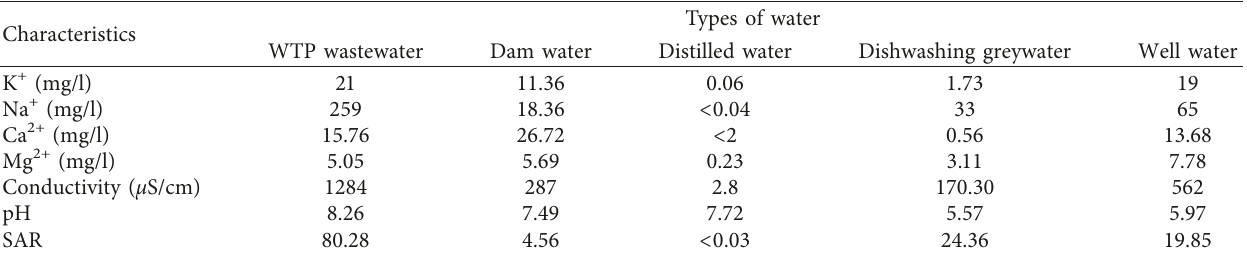
Figure 2: Convergent arrangement of the radicles of the seeds selected for the measurements. Table 1: Physicochemical characteristics of waters used for watering.